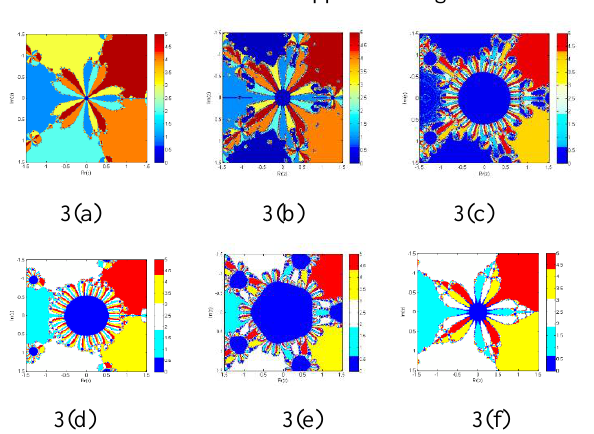
Fig. 3. (a-f), shows the basins of attraction of method (MS1- MS3, KM, CM, JM) respectively for non-linear function f_3 (s)=s^5+5 having roots-1.3,-0.4+1.3i,-0.4-1.3i,1.1+0.8i,1.1-